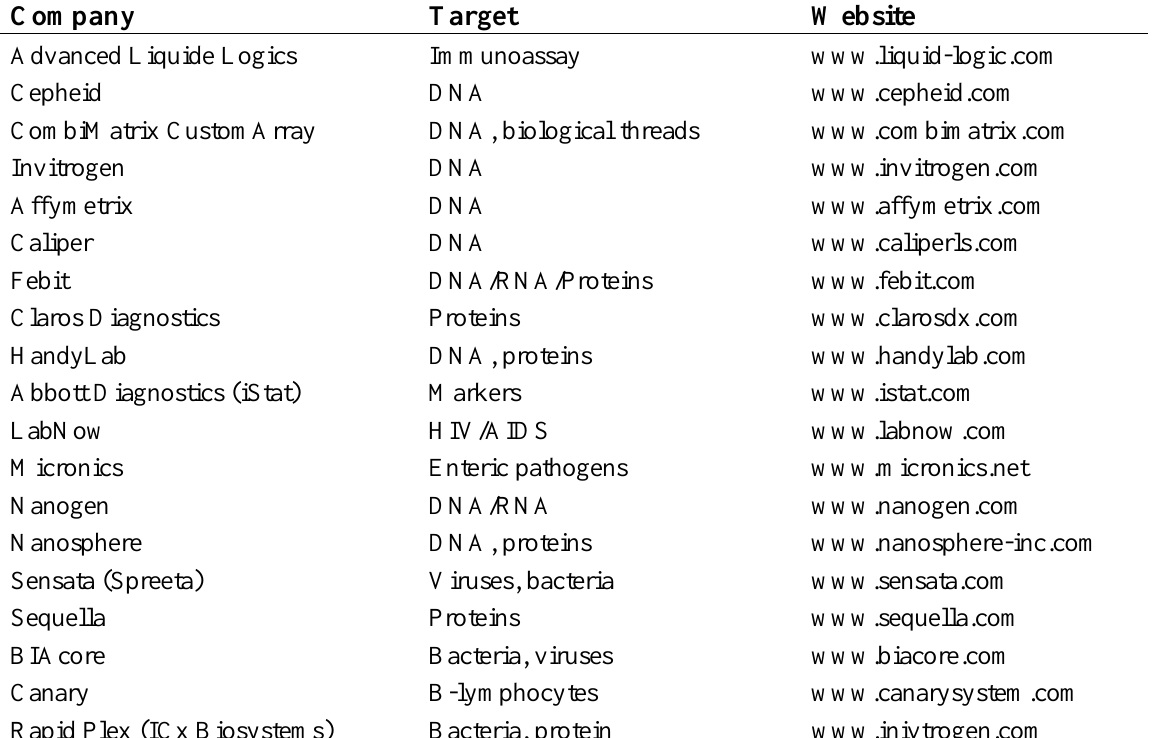
Table 1. Commercial available chip based pathogen sensing